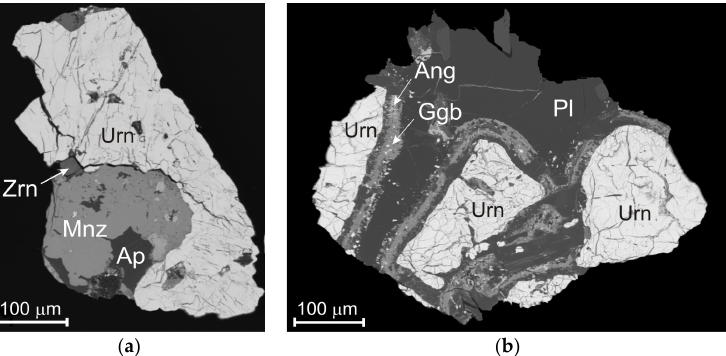
Figure 2. Uranium minerals in pegmatoid granitoid veins in the Dikoe U-occurrence of the Litsa area: ( a ) uraninite (Urn) intergrowth with monazite (Mnz), apatite (Ap), and zircon (Zrn); ( b ) galgenbergite (Ggb) and anglesite (Ang) rims between plagioclase (Pl) and uraninite. Rare small inclusions of thorite (about 10 µm) were found within monazite grains. Molybdenite forms thin rims on uraninite grains and together with galenite fills fractures in uraninite.